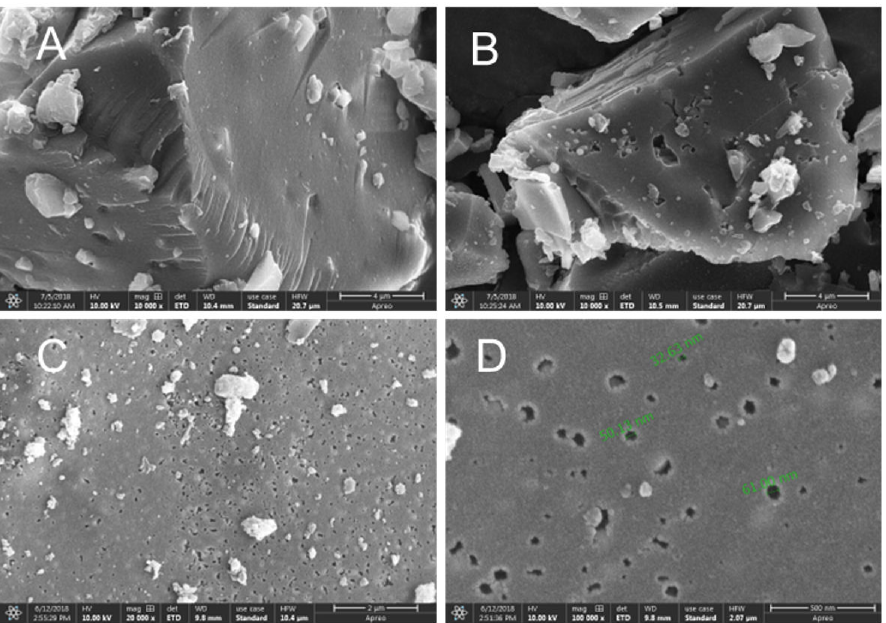
Figure 1. SEM images of Fe-BC-300 ( A ), SEM images of Fe-BC-600 ( B ), and SEM images of Fe-BC-900 ( C , D